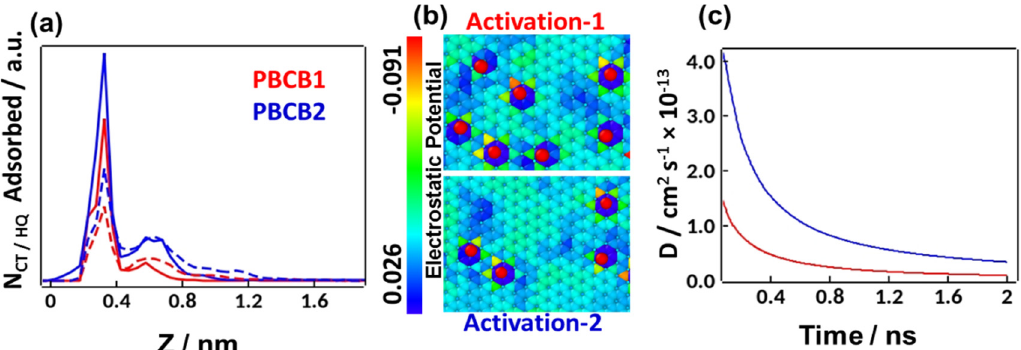
Figure 5. ( a ) Simulated number distribution of the HQ (dotted line) and CT (solid line) on PBCB1 (red) and PBCB2 (blue); ( b ) surface charge distribution of activation-1 (red) and activation-2 (blue); ( c ) diffusion coefficient of PBCB polymers on the activated surface of PBCB1 (red) and PBCB2 (blue).